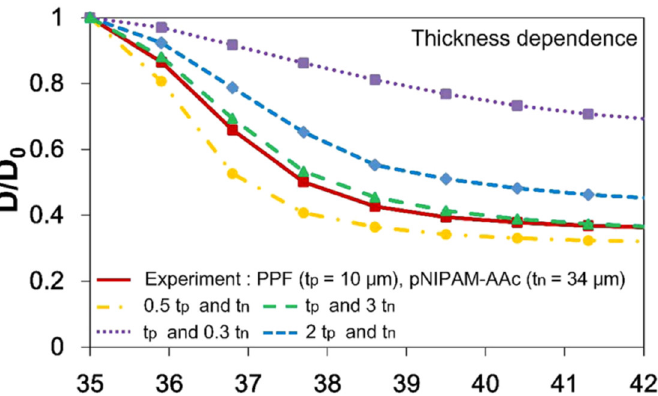
Figure 7. PPF and pNIPAM-AAc thickness and folding behavior. The thickness of the PPF and pNIPAM-AAc layers has a large effect on the folding behavior of polymeric devices. Reproduced with permission from Ref. [9]. Copyright 2015.